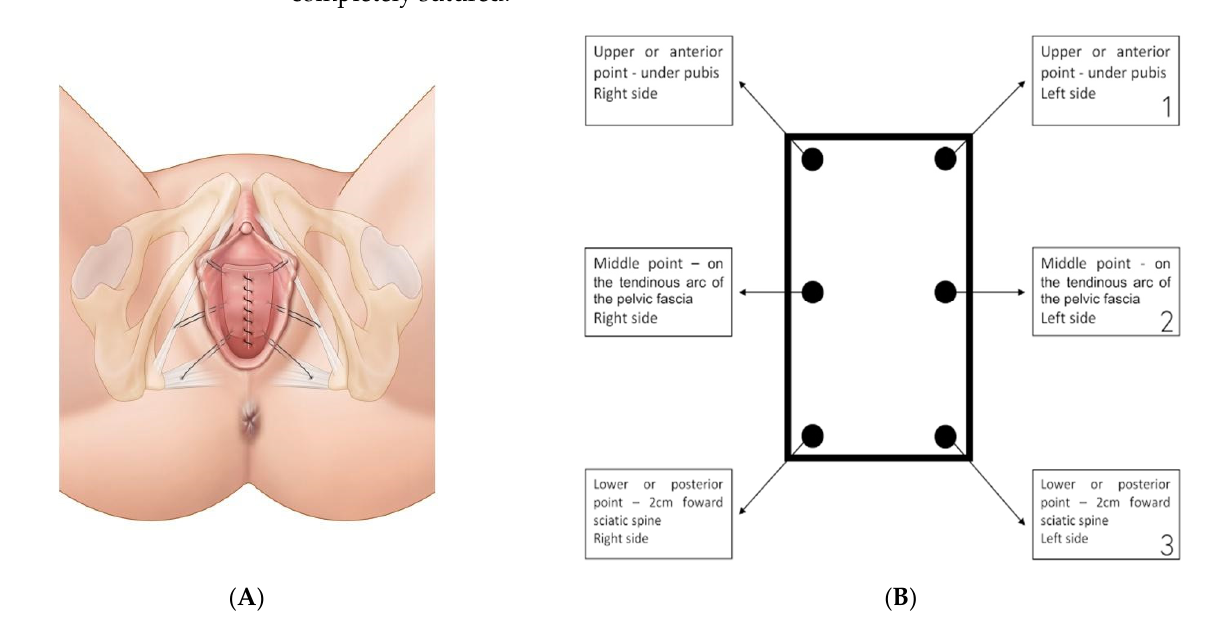
Figure 1. ( A , B ) Position of the 6 fixation points of the vaginal patch